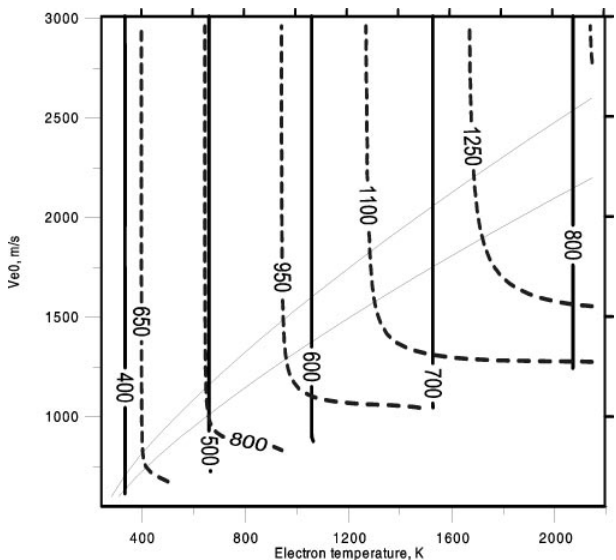
Fig. 6. Contours of the threshold speed (m/s) of 3 m Farley- Buneman waves at 110 km. We show only the regions for which the electron drift exceeds the threshold speed by a su(cid:129)cient amount. Solid contours : classic isothermal Farley-Buneman waves. Dashed contours : Farley-Buneman waves with thermal feedback when the wave vector is parallel to the E 0 (cid:2) B drift. The two light traces , which are only meant as a guide for the reader, approximate the lower bound and upper bound normally observed in the electron temperature near 110 km, based on the work of St.-Maurice et al. ,